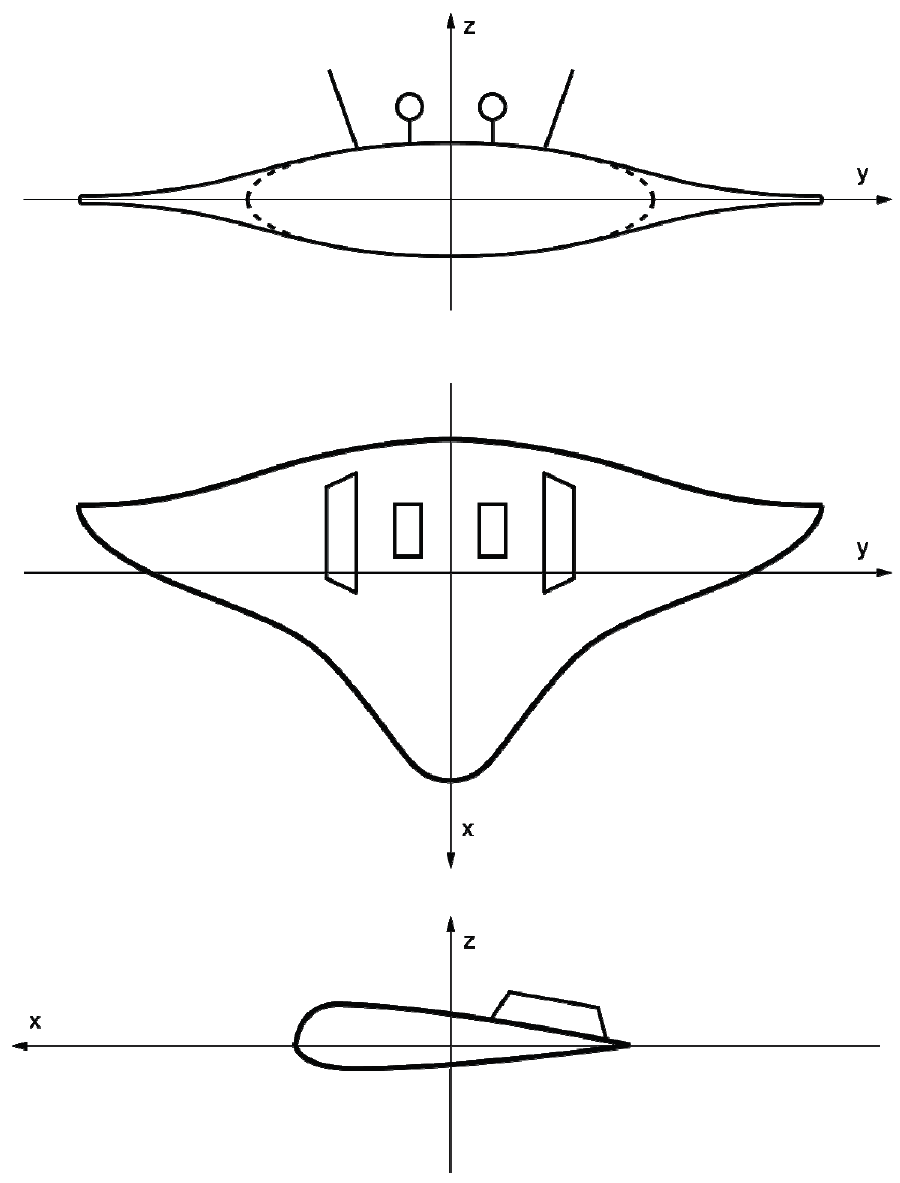
Figure 17. Flying wing: low-noise and efficiency compromises. The flying wing with overwing engine nacelles between the fins looks like the ideal low-noise configuration with shielding to the front, rear and sides; jet noise extending behind the nozzle is also shielded if the engine nacelle is well forward of the wing trailing-edge. Other attractive features of the configuration include (i) high cruise efficiency and (ii) large cabin